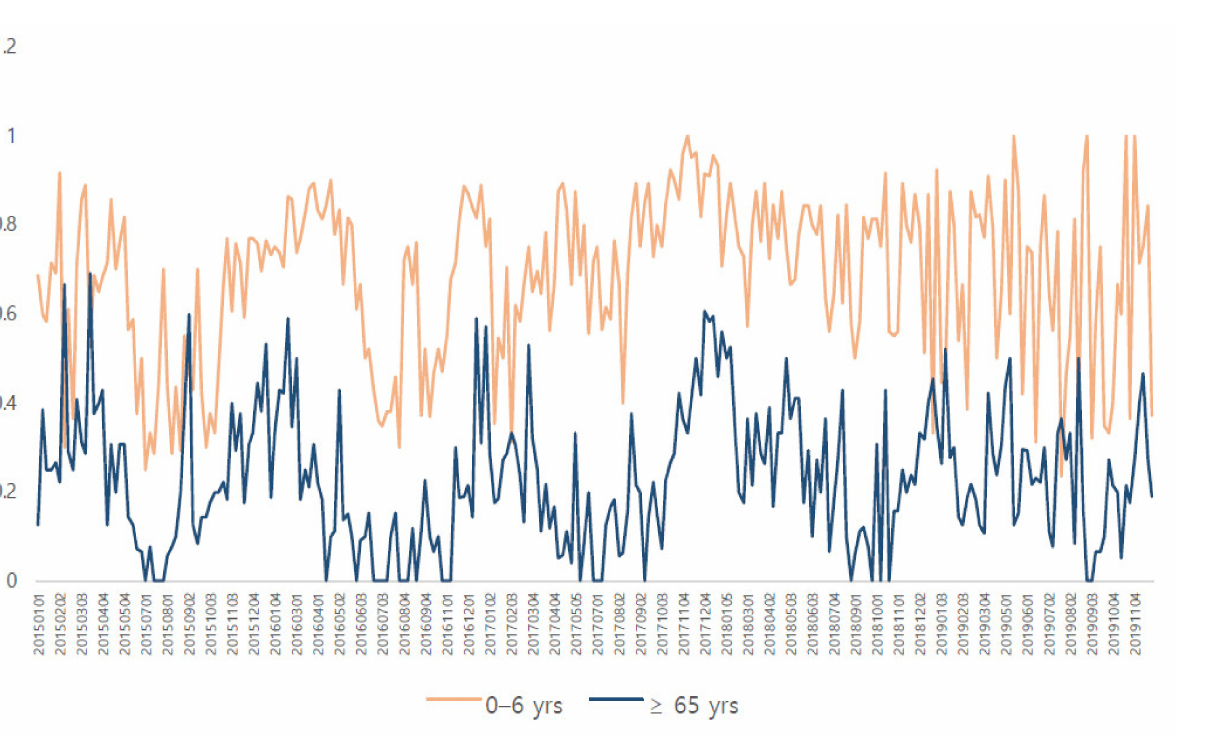
Figure 3. Comparison of respiratory viral infection rates in pediatric patients of 0–6 years of age and adults over 65 years of age with a high infection rate. Both graphs show a similar